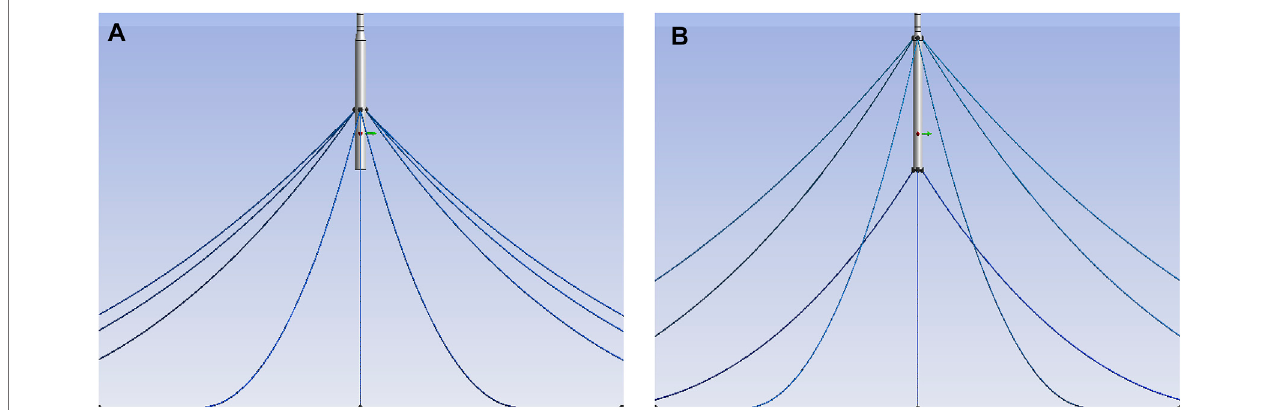
FIGURE 4 | Two types of mooring systems. (A) Conventional. (B)